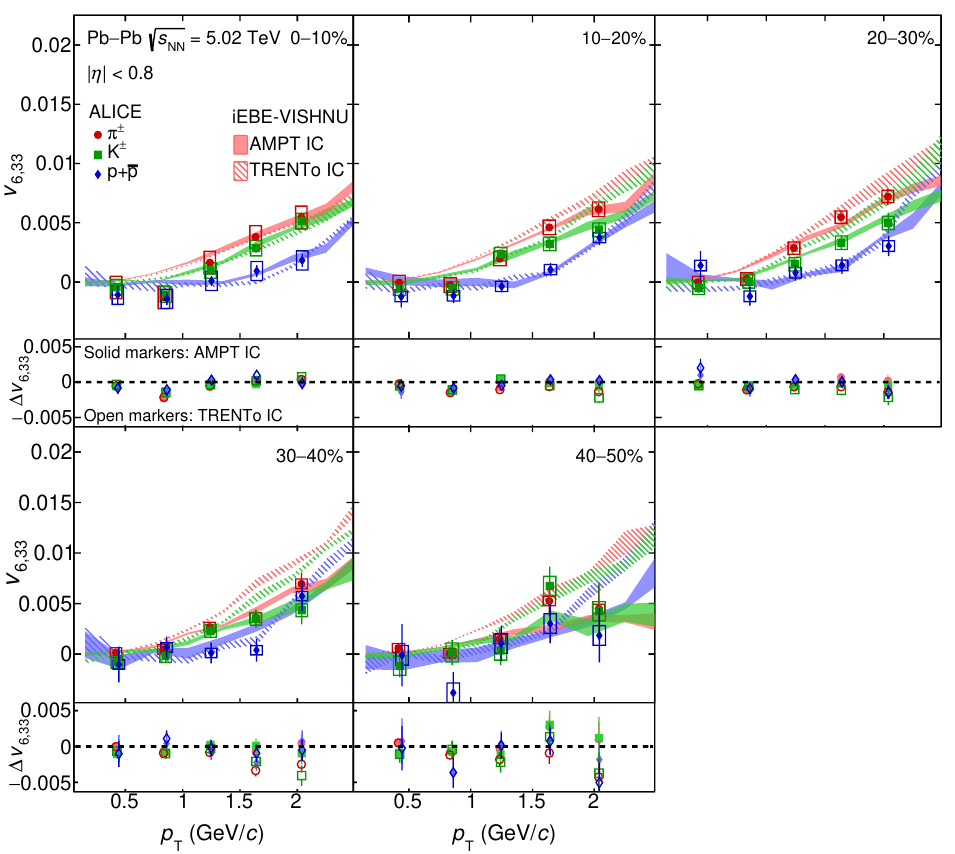
Figure 17 . The p T -di(cid:11)erential v 6 ; 33 of (cid:25) (cid:6) , K (cid:6) and p + p in the 0{10% up to 40{50% centrality p intervals of Pb-Pb collisions at s NN = 5 : 02 TeVcompared with iEBE-VISHNU hybrid models with two di(cid:11)erent sets of initial parameters: AMPT initial conditions ( (cid:17)=s = 0.08 and (cid:16)=s = 0) shown as solid bands and TRENTo initial conditions ( (cid:17)=s (T) and (cid:16)=s (T)) as hatched bands. The bottom panels show the di(cid:11)erence between the measurements and each model. Statistical and systematic uncertainties are shown as bars and boxes,